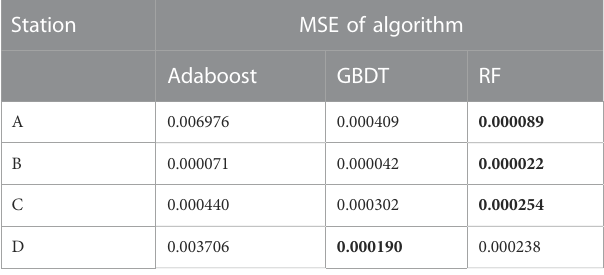
TABLE 3 Comparison of machine learning algorithms.